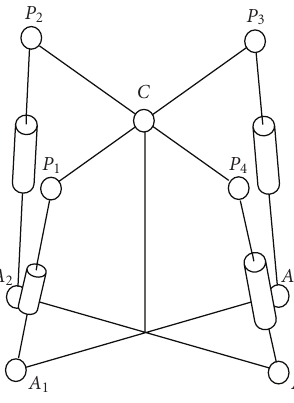
Figure 2: Parallel spherical mechanism.